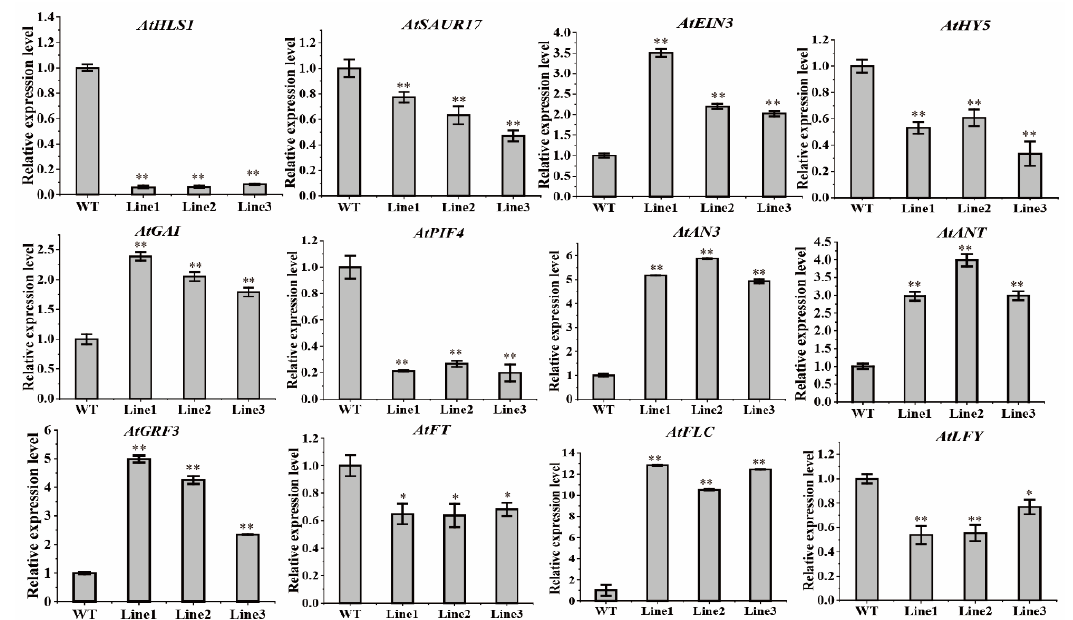
Figure 8. Relative expression levels of the downstream genes of BaZFP1 in Arabidopsis . WT, wild type. Lines 1–3 are independent transgenic lines. The data are the means ± standard deviations. Asterisks indicate significant differences between WT and transgenic lines (* p < 0.05; ** p < 0.01).